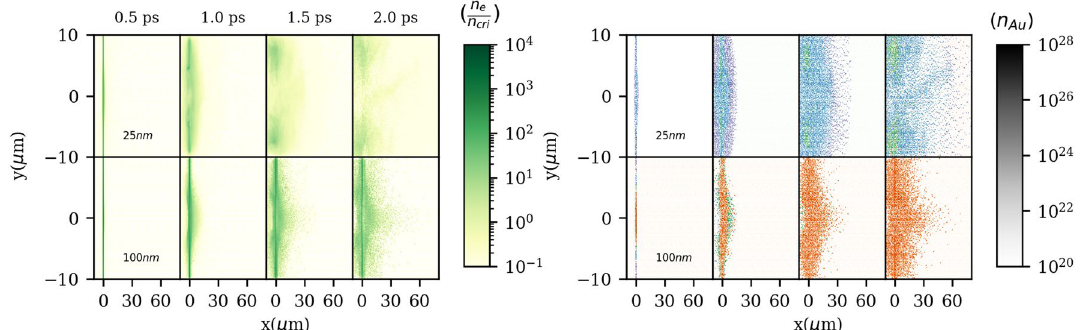
Figure 3. Left: electron densities normalized to n cri . Right: Au ion densities for charge states of (cid:31) Z = 0–51 (purple), (cid:31) Z = 51–61 (blue), (cid:31) Z = 61–65 (green), and (cid:31) Z = 65–77 (orange). The colorbar indicates gold particle 3 densities in m − and is the same for all ionization levels. Results belong to the FI + CI